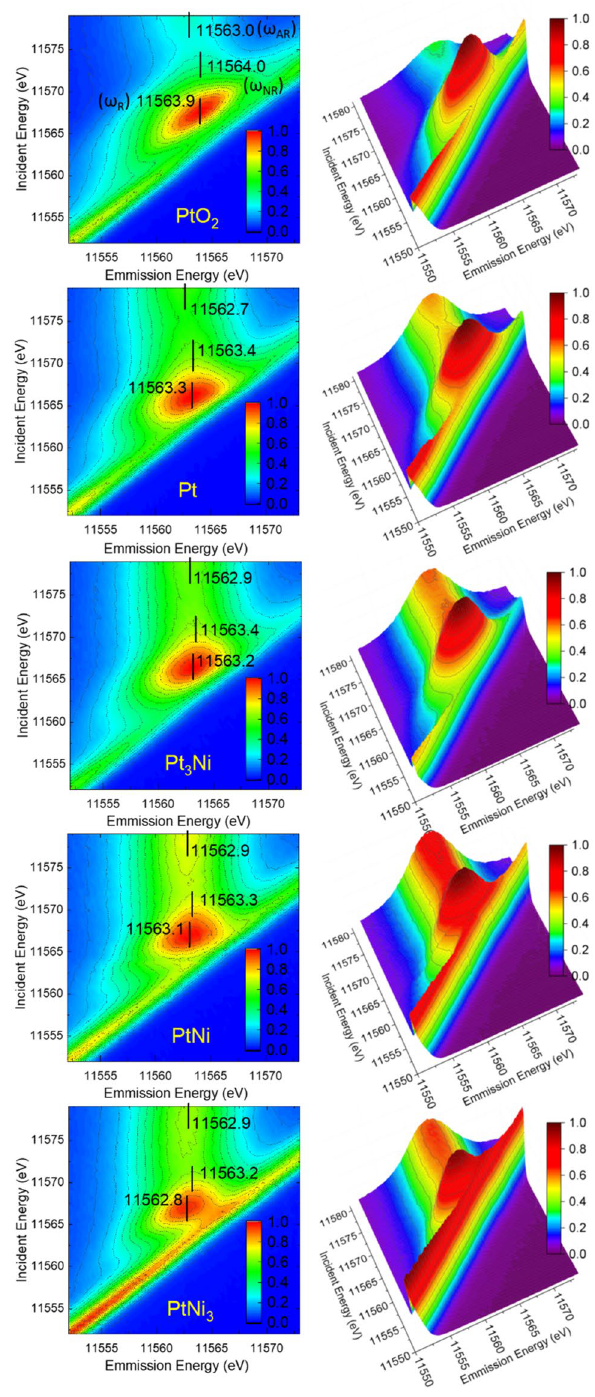
Figure 2. XES near the Pt L 3 -edge presented in two-dimensional and three-dimensional plots, showing the normalized intensity of RIXS and ES. The vertical bar on the left panel tracks the position of the emission in different energy region of excitation at (ω R ), near (ω NR ) and above (ω AR ) the resonance. The diagonal peak in the right panel displays the relative intensity of the elastic